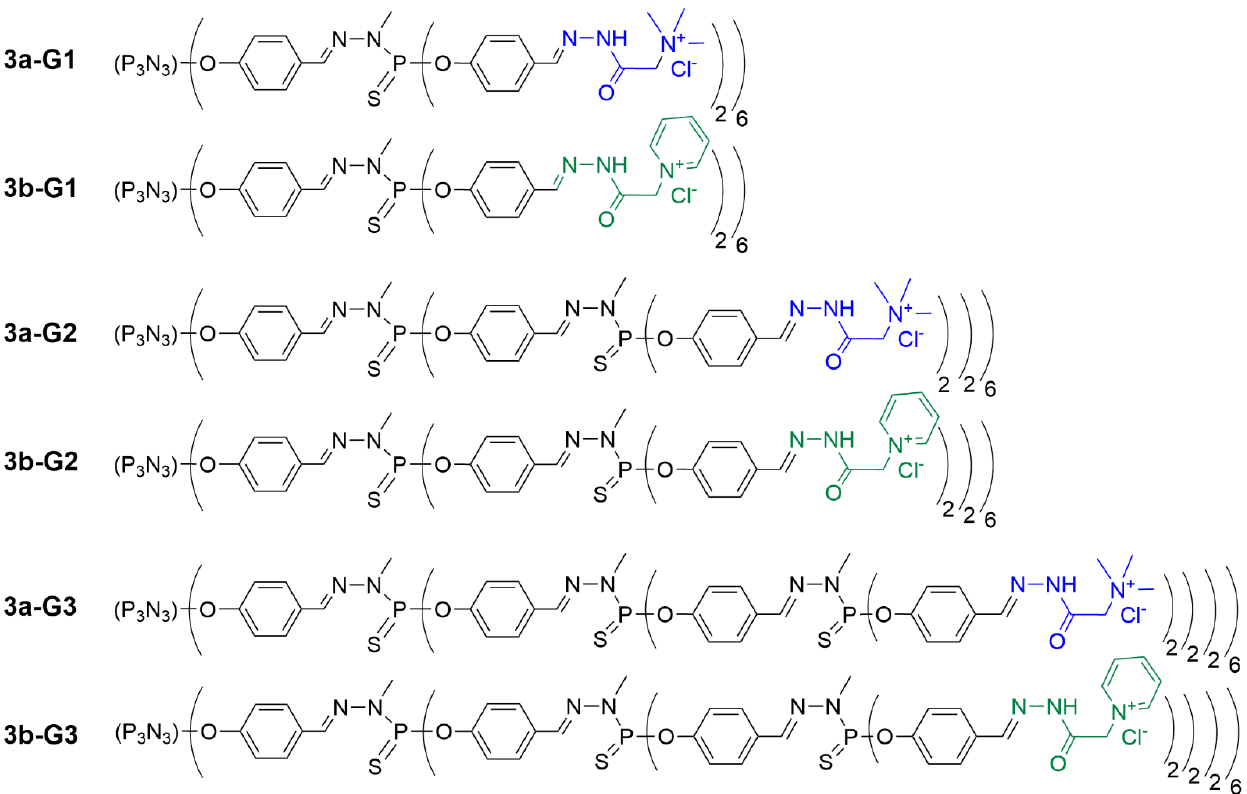
Figure 7. Linear representation of phosphorus dendrimers built from a hexafunctional core and functionalized with the Girard T reagent (in blue) or the Girard P reagent (in green) as terminal groups.